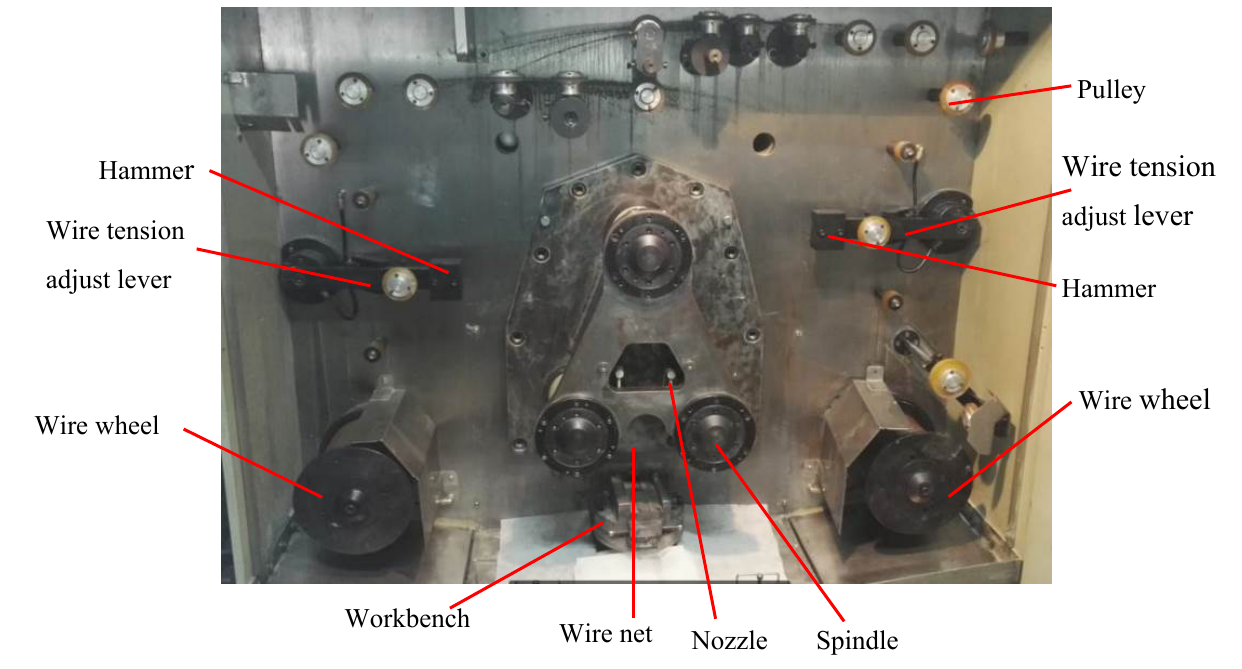
Figure 1. The structure of multi-wire sawing machine.